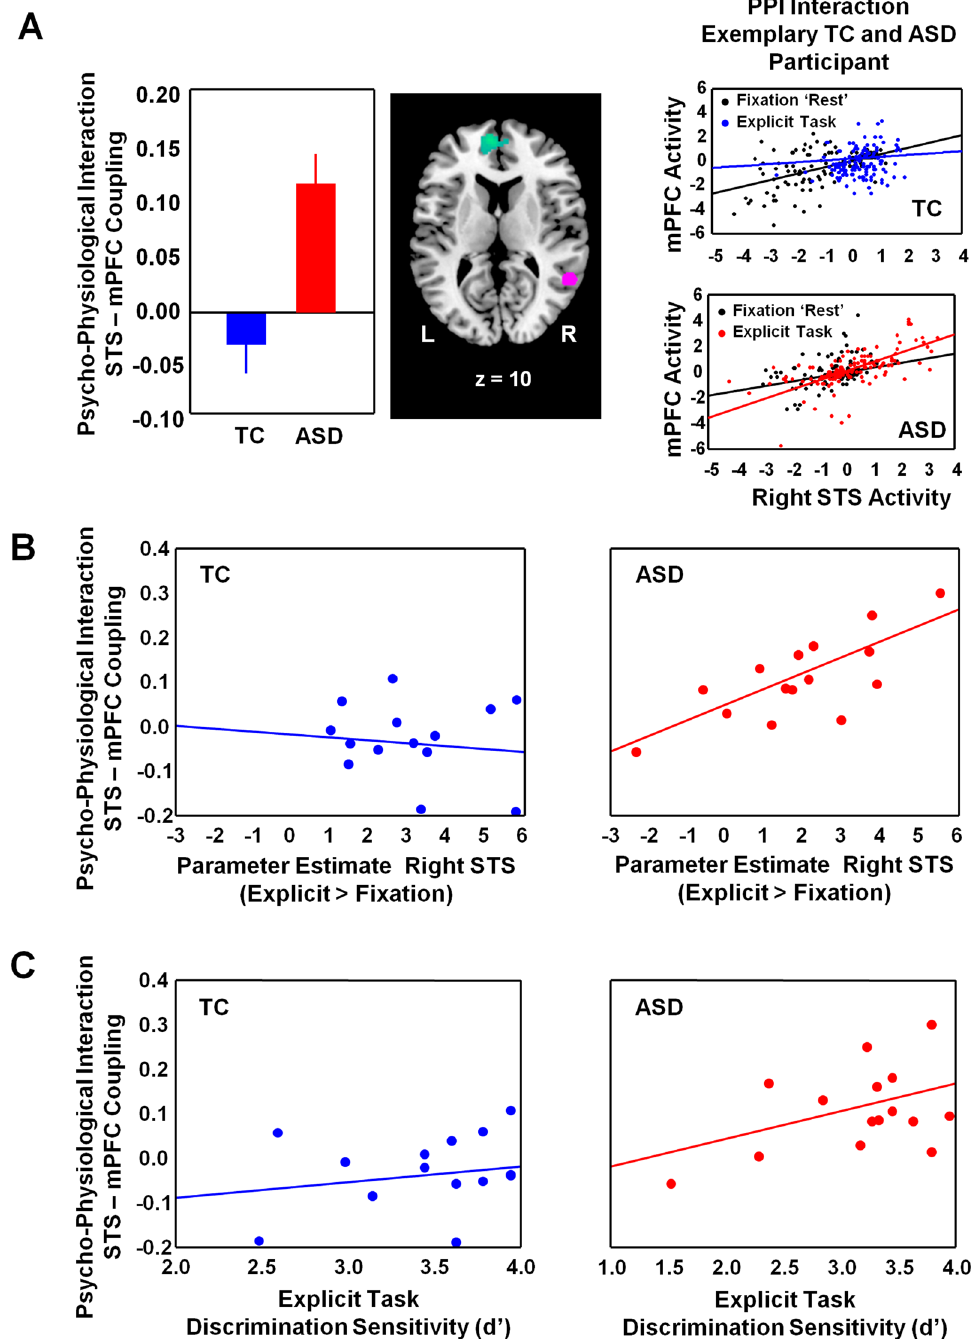
Figure 4. Psycho-physiological interaction analysis. Panel A visualizes the group difference in effective connectivity of right STS (purple) with a cluster in medial prefrontal cortex (mPFC) (blue-green) during explicit biological motion processing ( > fixation). The right panel visualizes the psycho-physiological interaction for an exemplary participant of the ASD and TC group. Panel B visualizes for each group (ASD, TC) the relationship between coupling (effective connectivity) of right STS with mPFC and parameter estimates of task-related brain activity in right STS (explicit > fixation). Panel C visualizes for each group (ASD, TC) the relationship between coupling (effective connectivity) of right STS with mPFC and discrimination sensitivity